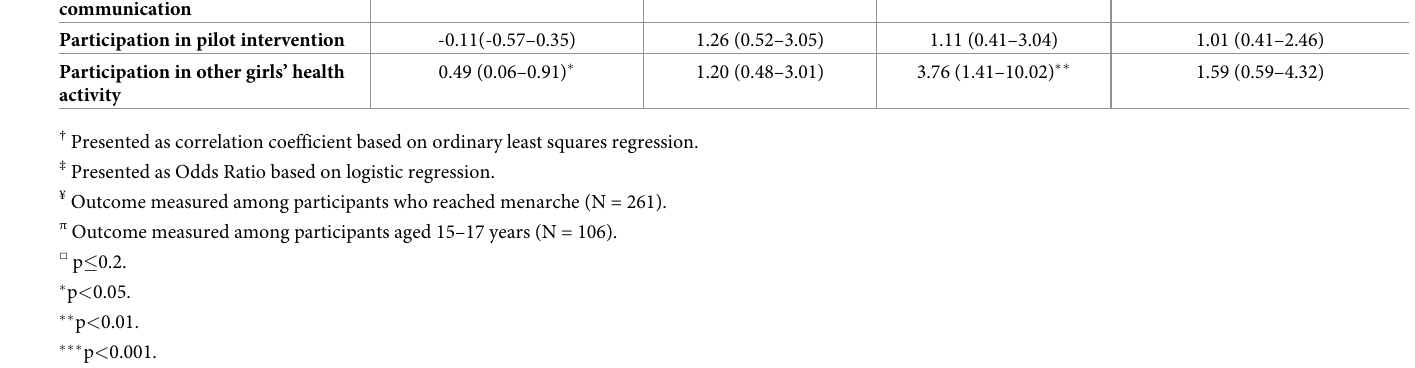
( Table 3 ). Having participated in a girls’ health program outside of school was strongly associ-